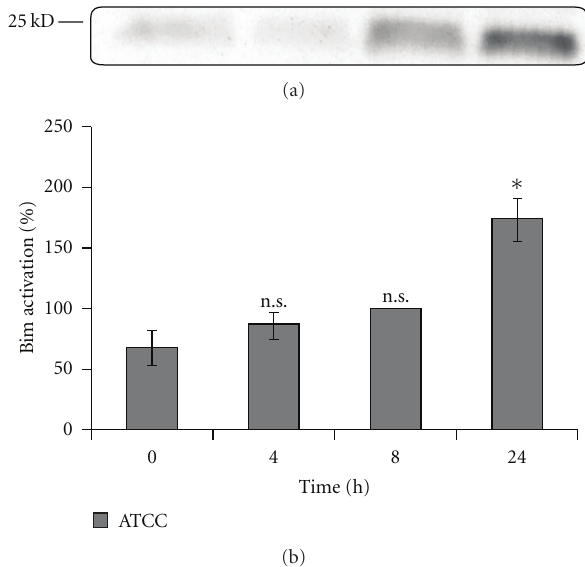
Figure 1: Time course of Bim upregulation in HCAEC induced by GBS. (a) Autoradiograph of western blot analysis of cell culture lysates demonstrating upregulation of Bim after 4, 8, and 24 h in comparison to unstimulated HCAEC. (b) Quantitative analysis of the Bim signaling pathway. Data shown represent mean expression in percent ± the standard error of the mean (SEM) of up to 4 independent experiments. The results after 8 hours are defined as 100 percent. ∗ Indicates statistical significant di ff erence ( P < . 05); n.s.: no significant di ff erence.